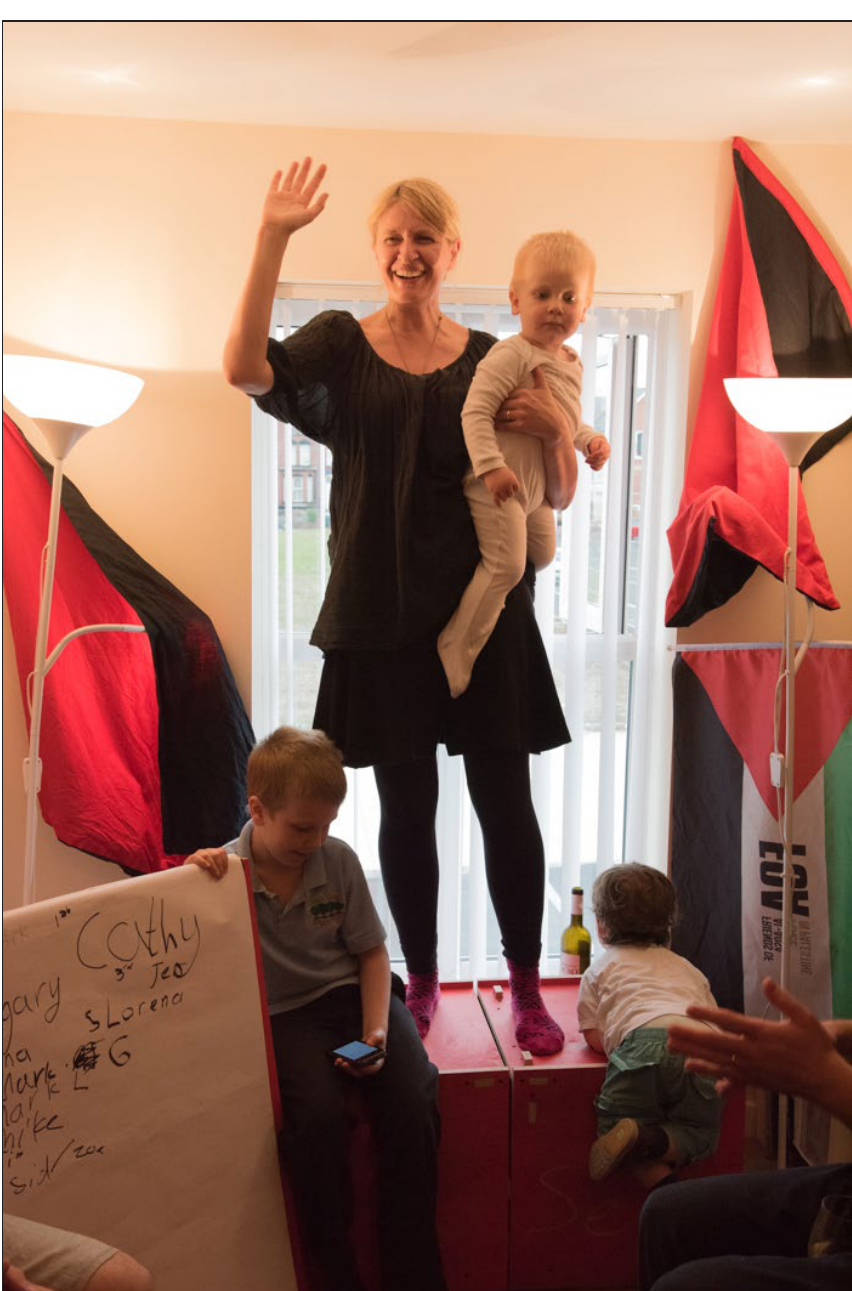
Figure 37: Lena Šimi ć , Lena and James at Manifesto Slam , The Institute for the Art and Practice of Dissent at Home, Liverpool, June 2015, Photo by Mark